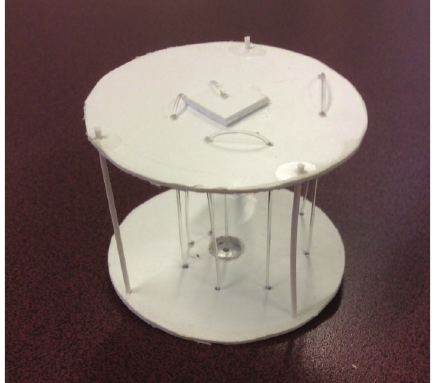
Figure 7: Nautilus phantom.